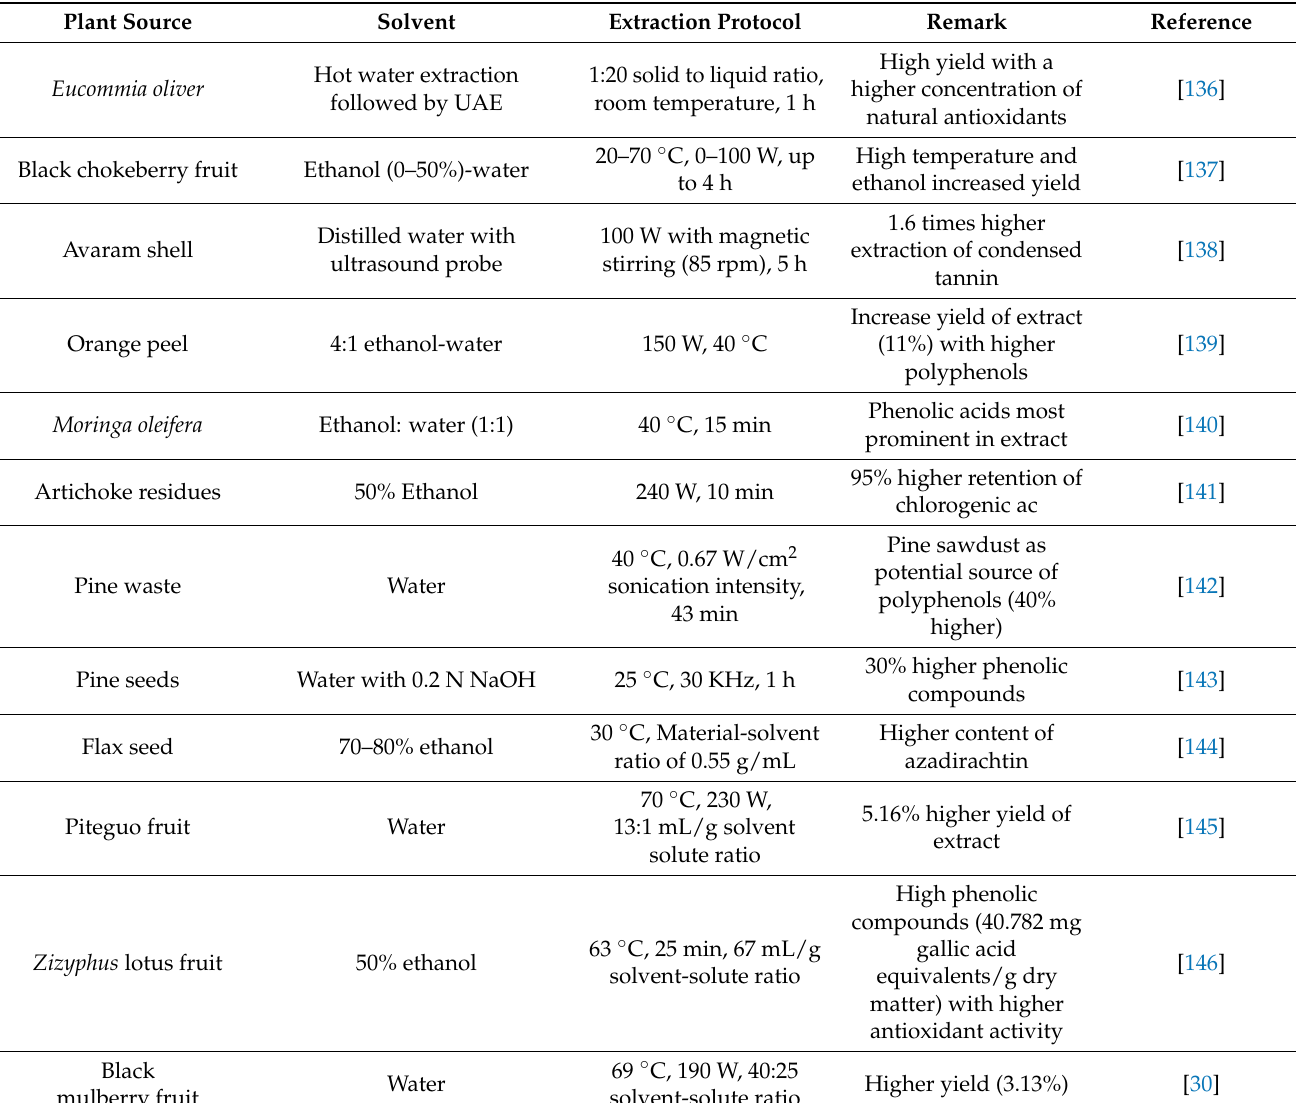
Table 6. Ultrasound-assisted extraction (UAE) of bioactive compounds from plant